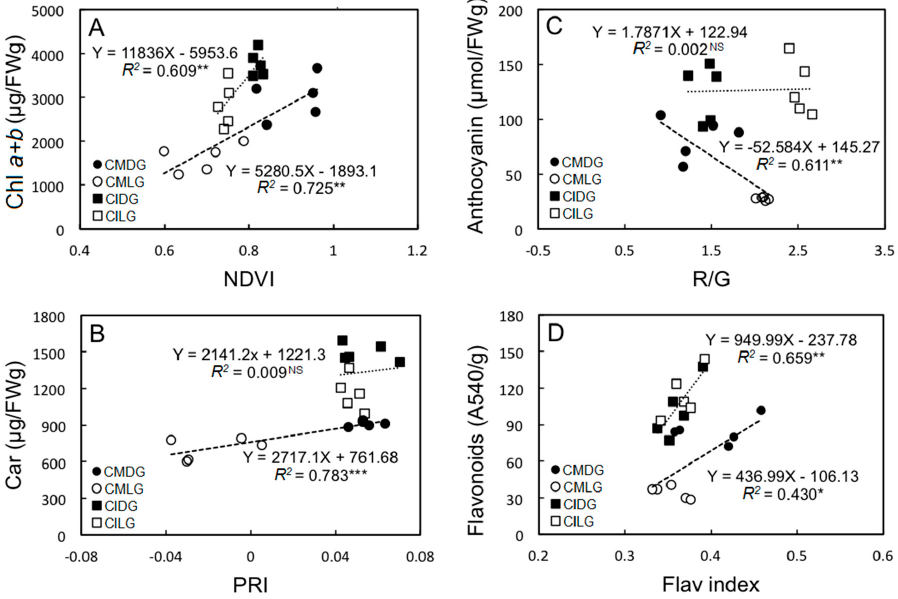
Figure 5. Correlations between Chl a + b and NDVI ( A ), Car content and PRI ( B ), Ant content and red-green ratio (R/G) ( C ), and Fla content and FlavI ( D ) of different leaf sectors in Calathea makoyana and C. insignis . Black circle (dark green leaf sector in C. makoyana ; CMDG) and white circle (light green leaf sector in C. makoyana ; CMLG) represent dark green and light green leaf sector in C. makoyana , respectively. Black square (dark green leaf sector in C. insignis ; CIDG) and white square ((light green leaf sector in C. insignis ; CILG) represent dark green and light green leaf sector in C. insignis , respectively. NS represents not significant, * p < 0.05, ** p < 0.01, *** p < 0.001.